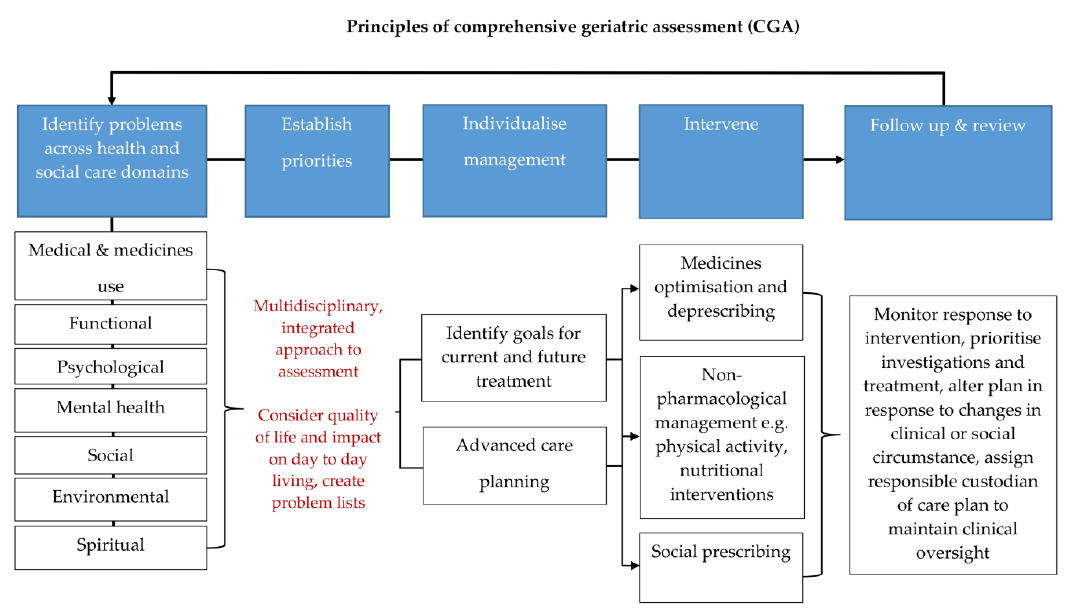
Figure 1. Principles of comprehensive geriatric assessment (CGA). CGA is an